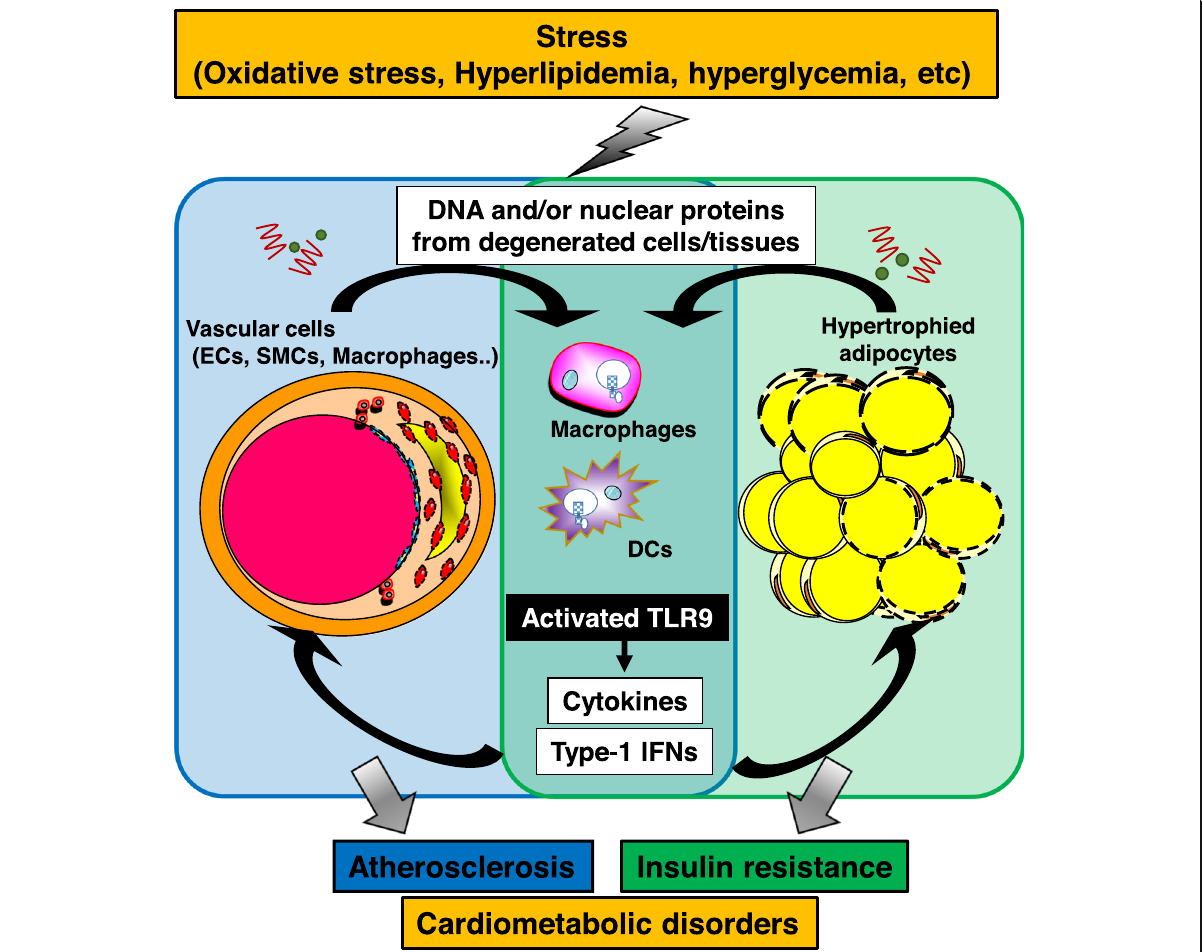
Fig. 5 Role of TLR9 in the development of cardiometabolic disorders. DNA fragments and/or nuclear proteins released from damaged cells/ tissues activate immune cells such as macrophages and DCs through TLR9, leading to the development of inflammation in these tissues, which is central in the pathogenesis of cardiometabolic